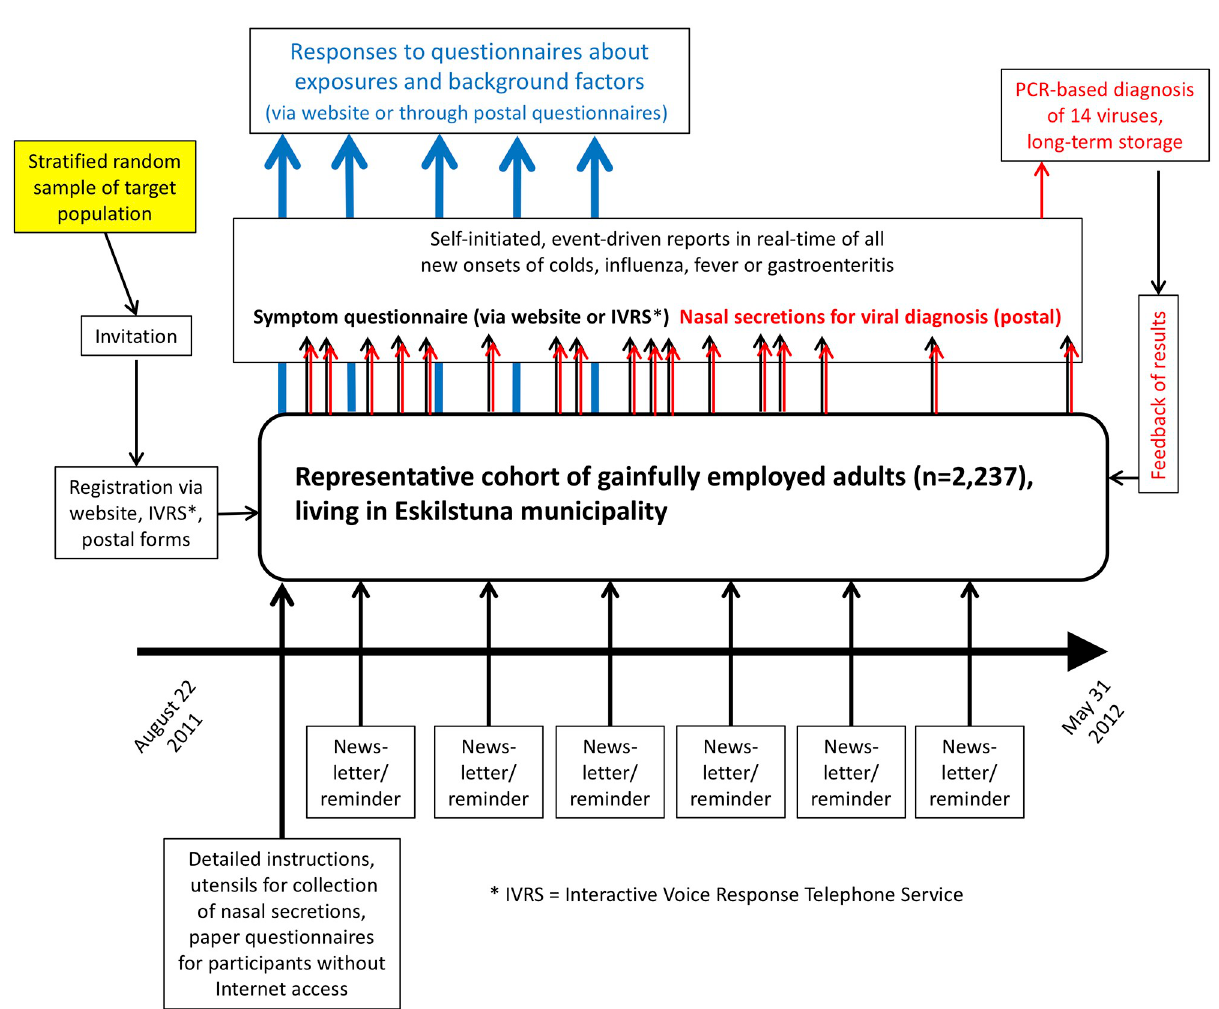
Fig 1. Overview of the study design, including the infectious disease surveillance scheme.